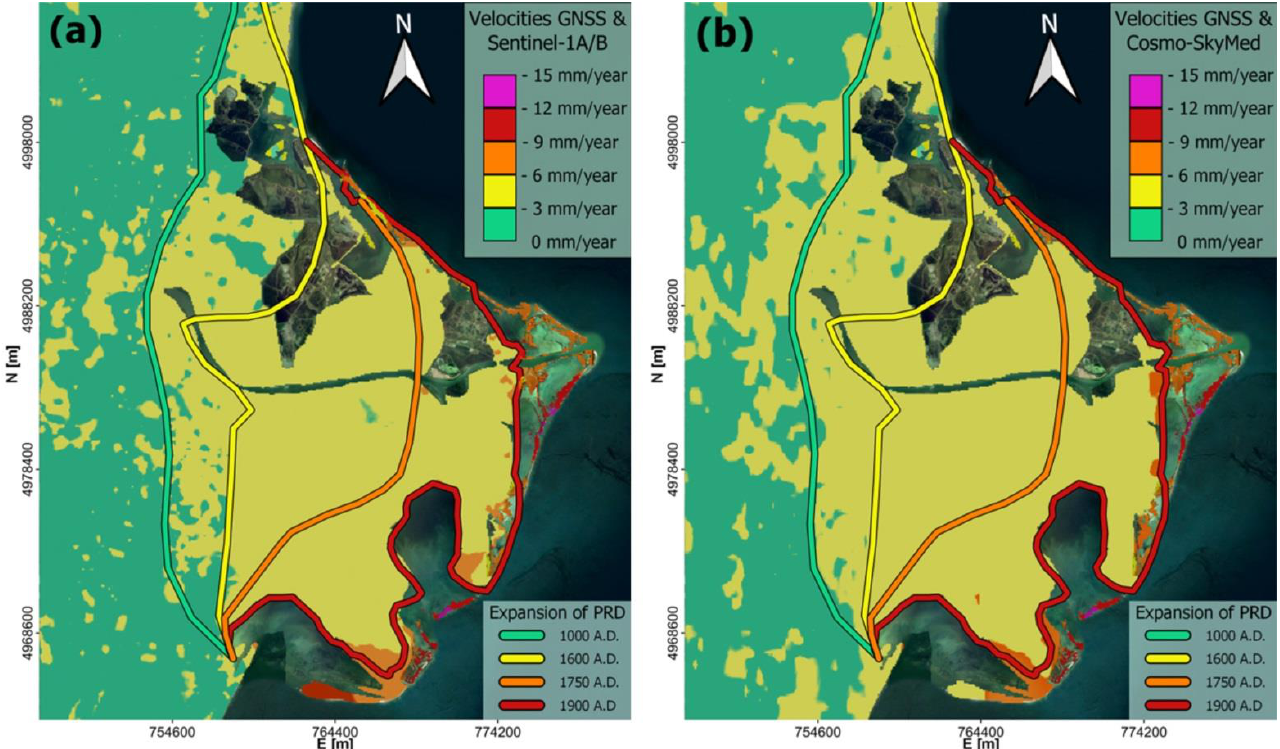
Figure 11. Interpolation of the available GNSS-Sentinel-1 ( a ) and GNSS-CSK ( b ) data over the study area using the Kriging method with a grid size of 150 m (regional